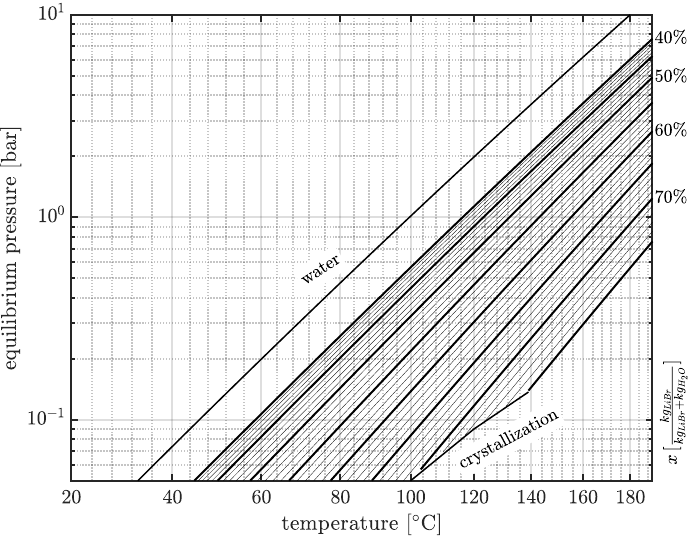
Figure 7. Van ’t Hoff diagram for aqueous LiBr—property data taken from [45]. In Figure 8 (top), the useful (discharging) isentropic enthalpy differences, ∆ h isen , of the water vapor are drawn over driving temperature difference ∆ T (left) and